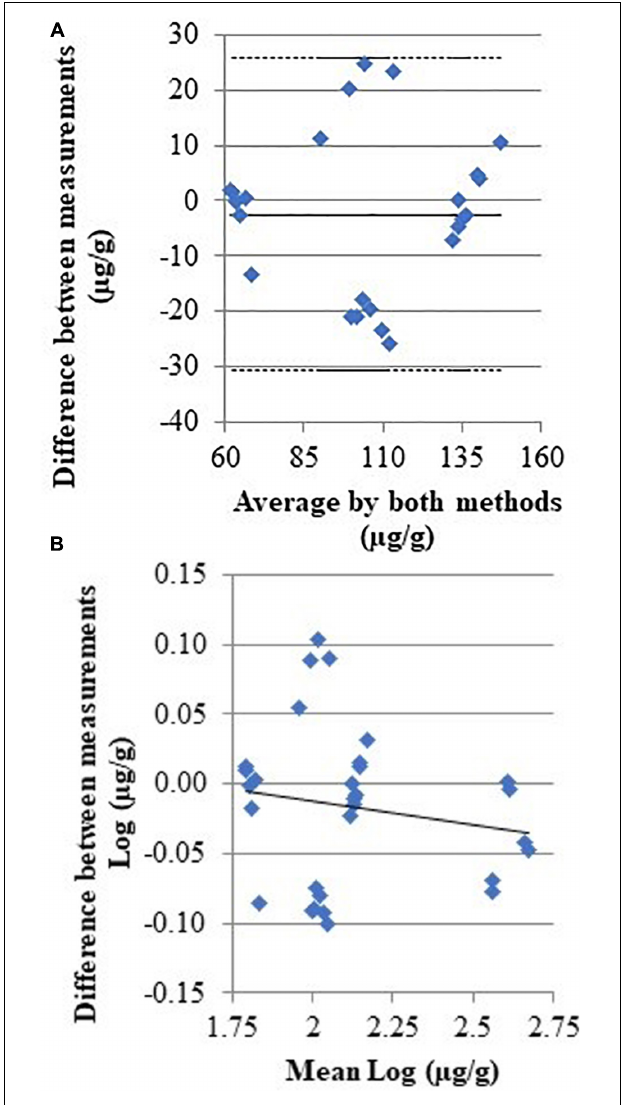
FIGURE 3 | Scatter diagrams with the average and the difference of histamine concentrations detected by HPLC and biosensor. (A) Full line indicate the regression line; (B) full and dashed lines indicate the mean difference and 95%CI, respectively [CI95% –30.72;